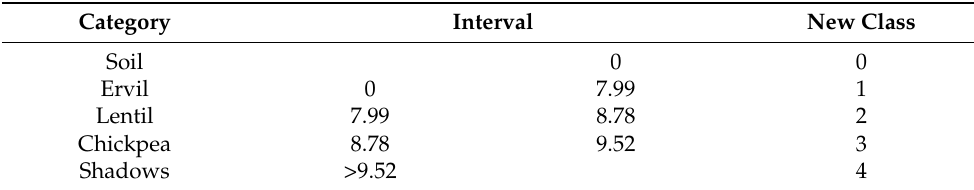
Table 5. Used thresholds for reclassification of VSI AM into new classes. Category